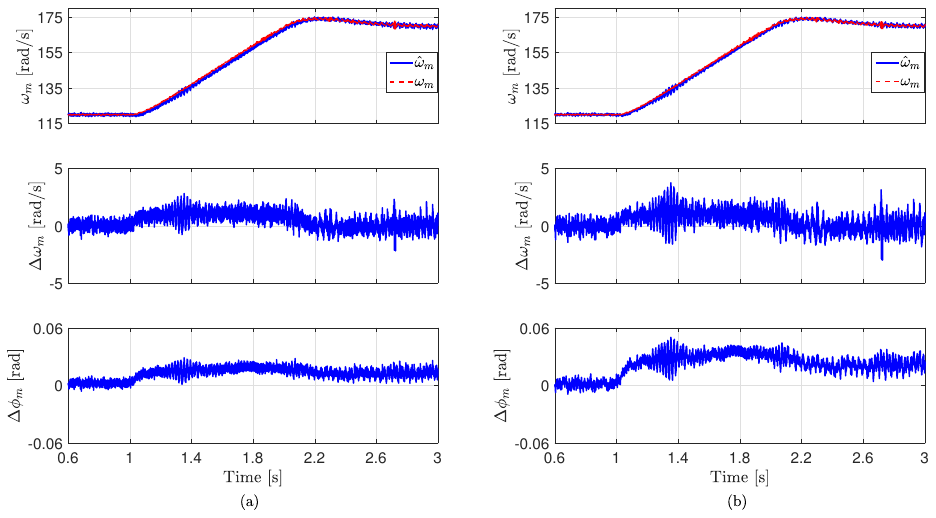
Figure 5. Experimental results at changes of the rotation speed of the rotor: ( a ) LPS-MRAO, and ( b ) traditional MRAO.